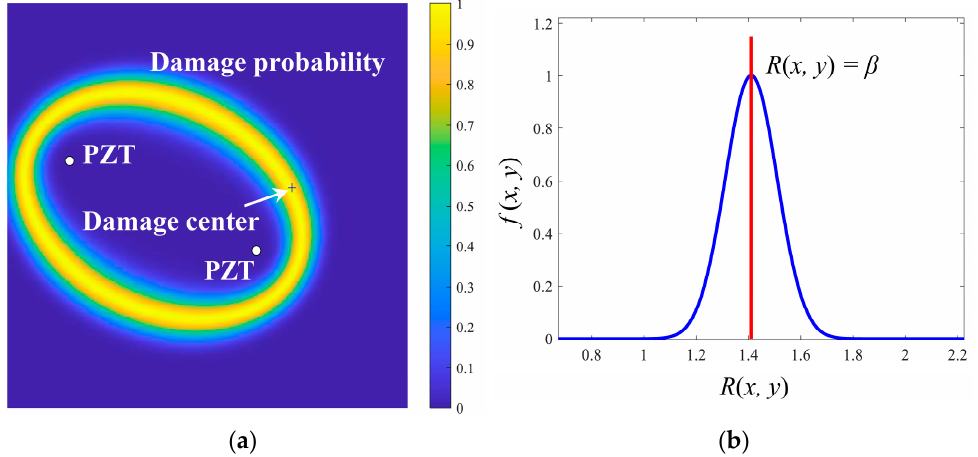
Figure 5. Damage probability distribution of specific paths. ( a ) Damage probability distribution; ( b ) The normal distribution.